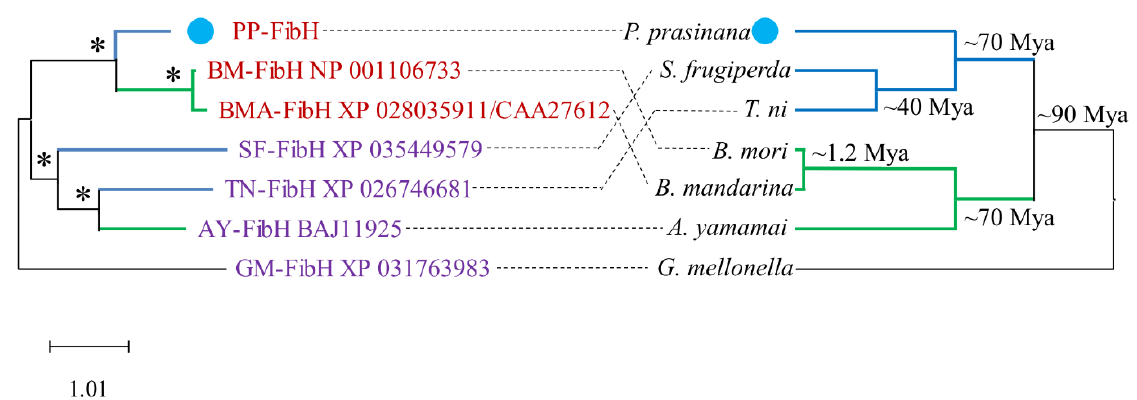
Figure 5. Comparison of available Fib-H protein sequences (left). The P. prasinana (PP) Fib-H sequence (blue dot) is more similar to that of B. mori (BM) and B. mandarina (BMA), these three sequences form a single well-supported cluster based on the similar structure of their crystal region (Class I sequences are marked by red text). Fib-H sequence from Antheraea yamamai (AY), another representative of superfamily Bombycoidea, forms one well supported cluster with two sequences from Noctuoidea ( Spodoptera frugiperda , SF, and Trichoplusia ni , TN). Based on crystal region structure they all belong to Class III (text marked by violet), including the outgroup sequence from the pyralid moth, Galleria mellonella (GM). Corresponding species tree with time divergence of nodes is shown on the right. All species from Bombycoidea superfamily have branches highlighted in green and all species from Noctuoidea superfamily have branches highlighted in blue (Mya = million years ago). Fib-H tree (ML) exhibits full resolution and good statistical support. Branches with statistical support (aBayes values) higher than 70 are marked with asterisks.